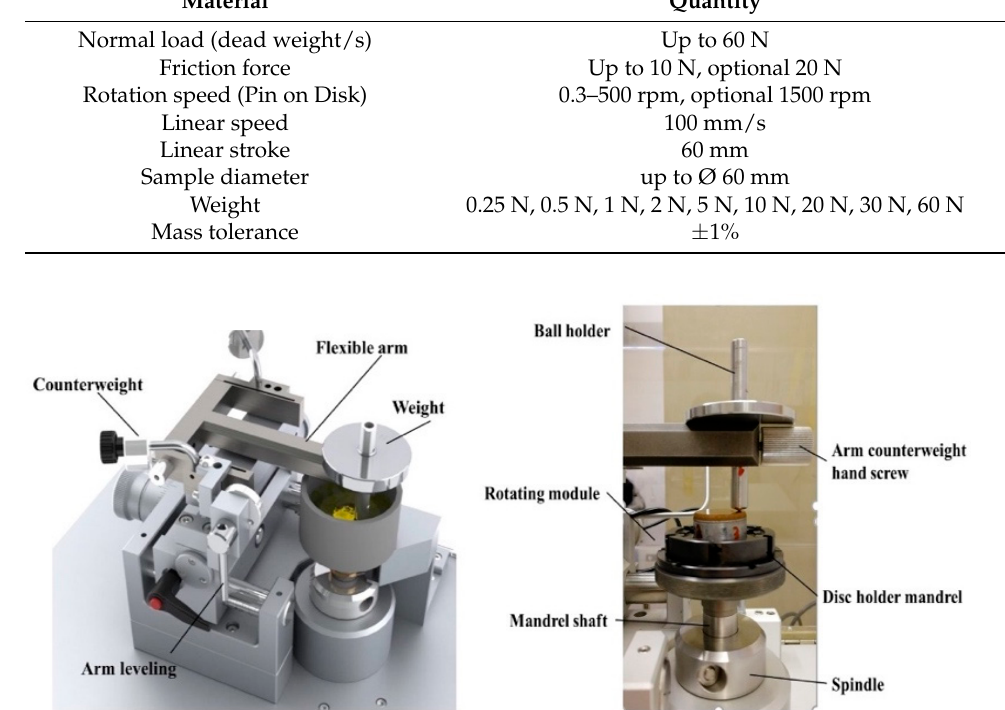
Figure 4. Functional scheme of the Anton Paar pin-on-disk tribometer and rotating module. Table 3. Tribometer technical specifications.